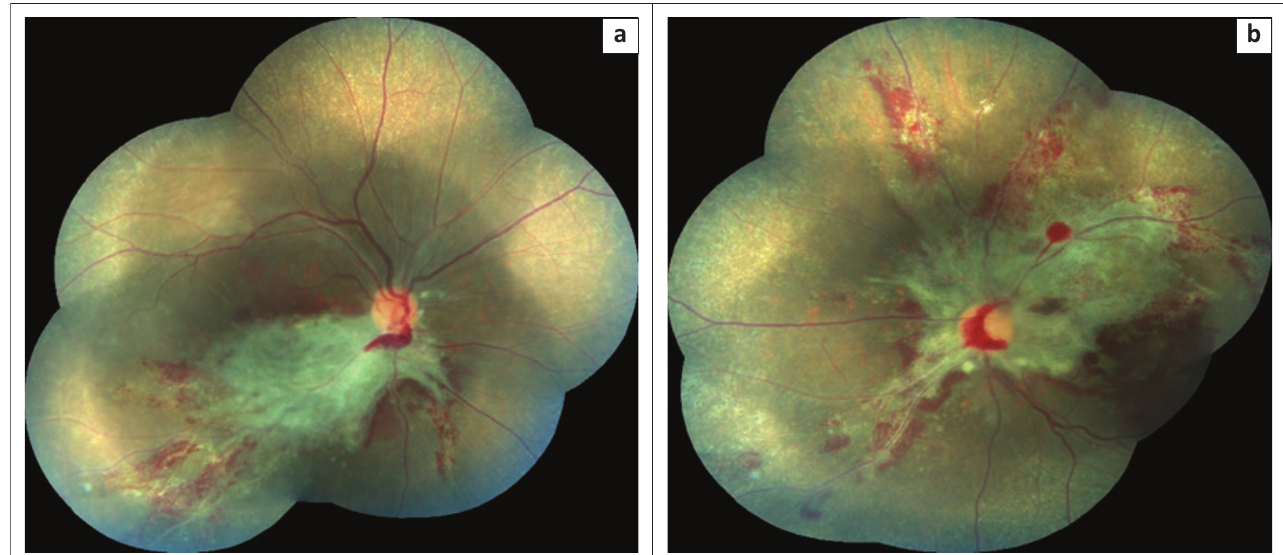
FIGURE 2: Patient from Figure 1 with bilateral cytomegalovirus retinitis after six intravitreal ganciclovir injections to both eyes.